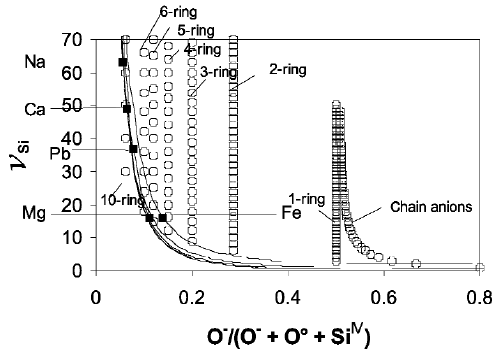
Fig. 7. Polymerization paths of EPA model com- pared with compositions of discrete polymeric units which may form in melt at various SiO 2 contents. Adopted polymerization constants in constructing various curves are those of table V. Location of con- solute points overlap, for comparative